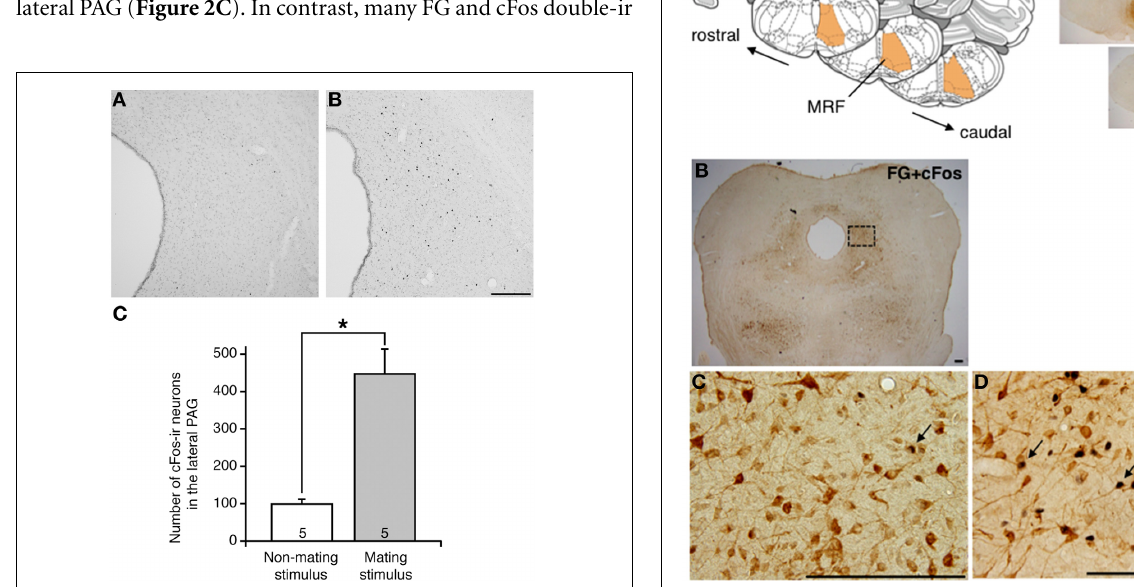
FIGURE 1 | cFos expression in the lateral PAG in representative female rats following (A) non-mating stimulus and (B) mating stimulus. cFos-ir neurons are shown by black dots. (C) The mean number of cFos-ir neurons in the lateral PAG in OVX+E2 rats after mating stimulus (solid bar) was significantly higher than that in non-stimulated control rats (open bar) ( ∗ P < 0 . 05; Student t -test). Values are shown as means ± SEM. The numbers in each column indicate the numbers of animals used. Scale bar, 100 μ m.